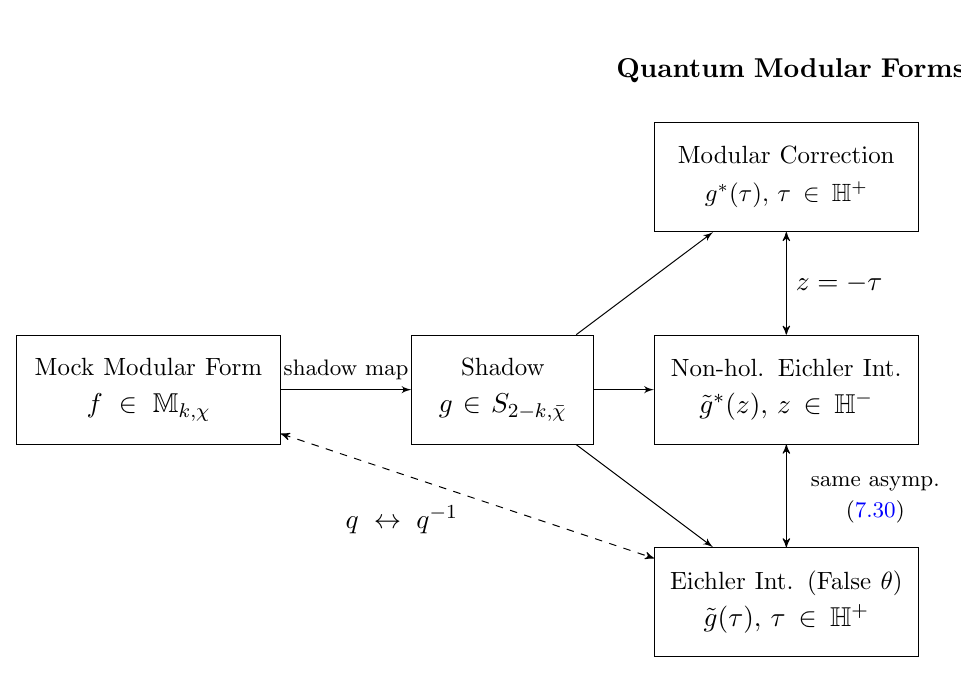
Figure 9 . The relation between the di(cid:11)erent modular objects involved. The dashed line is to denote that the relation is non-unique in both